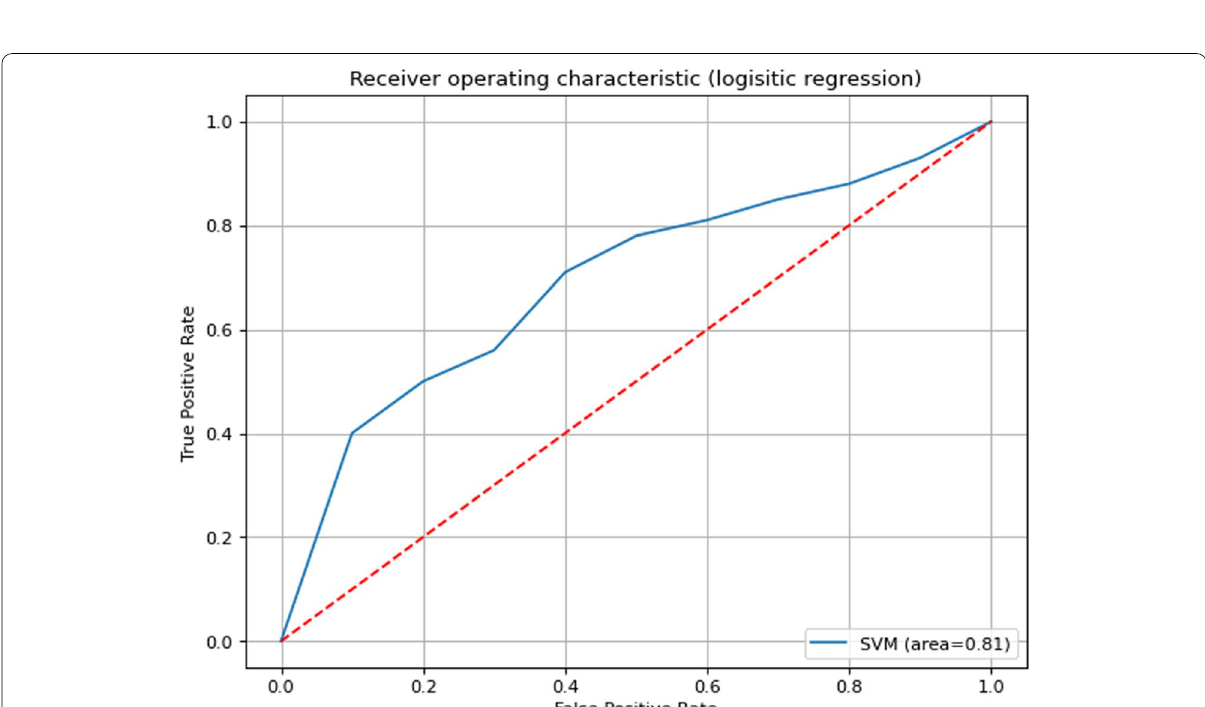
Fig. 23 ROC curve for our proposed model with logistic